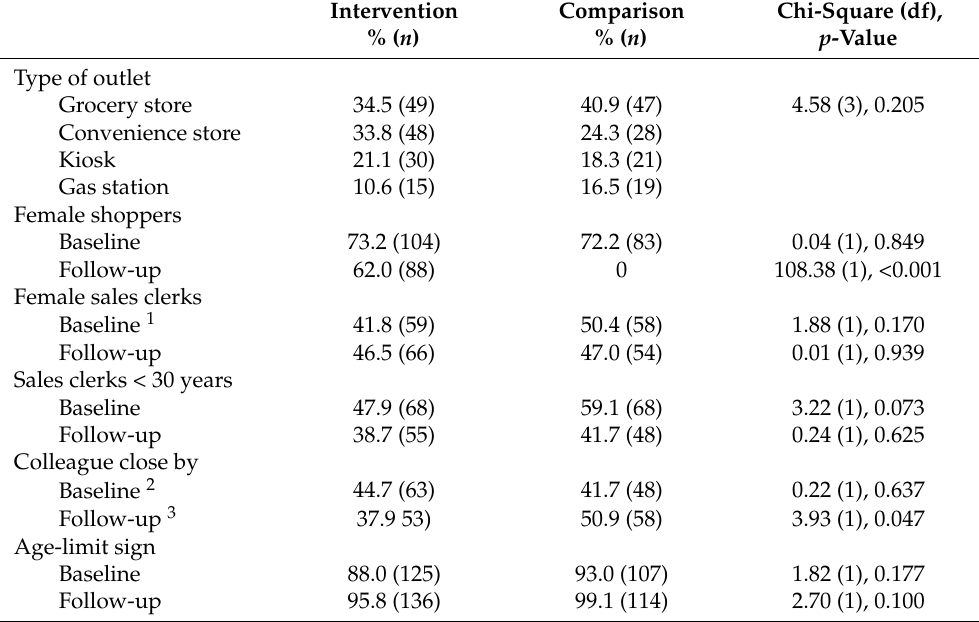
Table 1. Characteristics of the comparison and intervention group at baseline and follow-up. At both baseline and follow-up, 257 test purchases were conducted at the same outlets. Of these purchase attempts, 142 were conducted in the intervention group (6 municipalities) and 115 in the comparison group (7 municipalities).